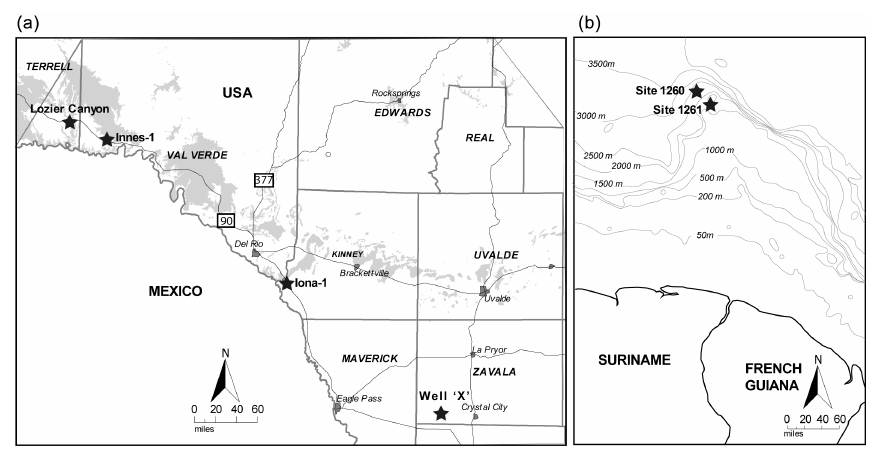
Figure 2. Site locations. (a) SW Texas map showing core locations (black stars): grey shading – Eagle Ford Gr., outcrop belt. (b) Demerara Rise site